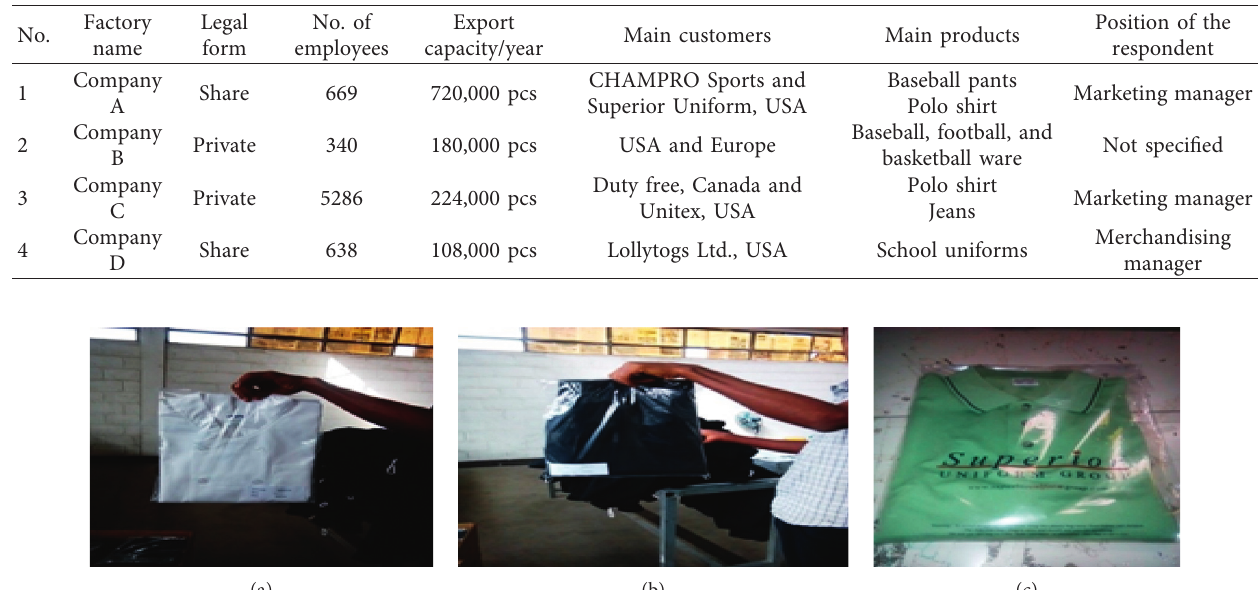
Table 5: Background information about selected garment companies.